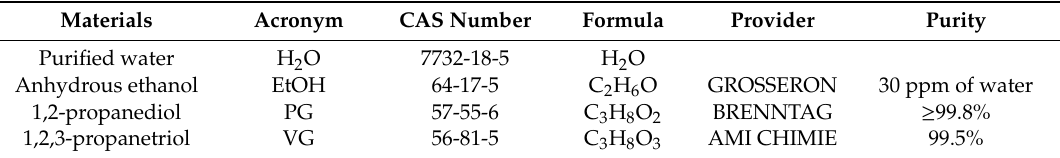
Table 1. List of the studied pure liquids and general information about them.